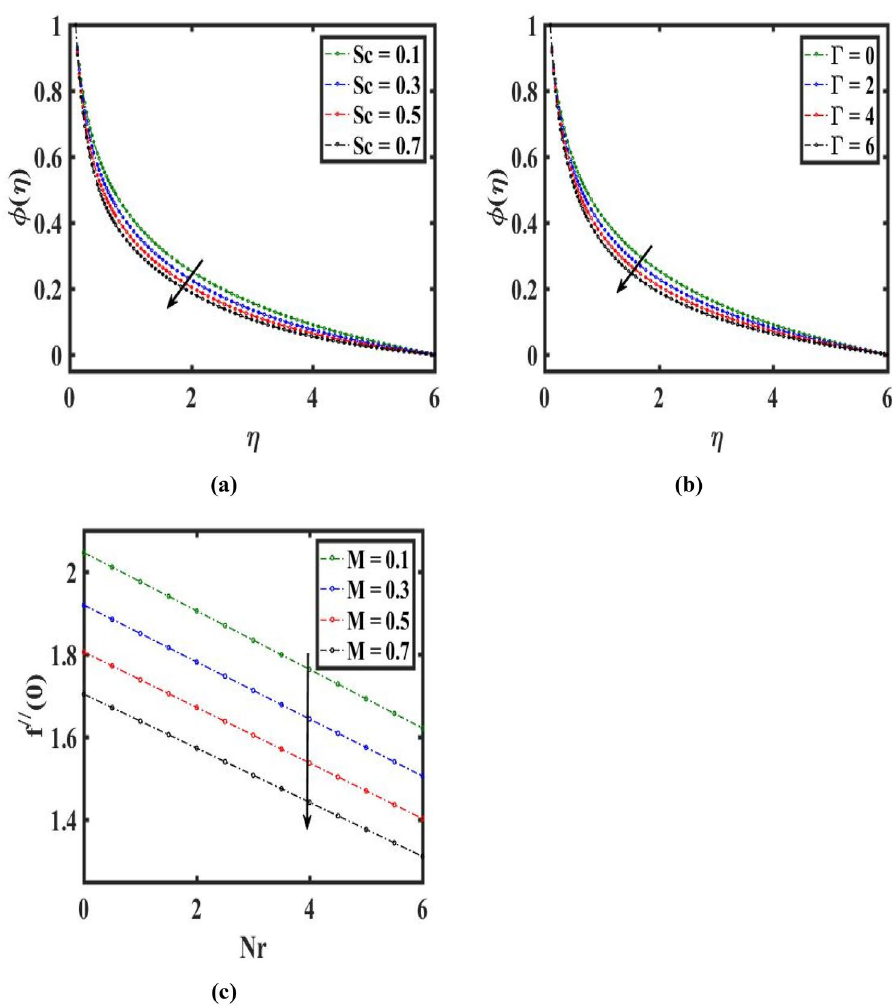
Figure 6. Effect of Schmidt number Sc , chemical reaction Ŵ , Hartmann number M , and buoyance ratio Nr on concentration φ(η) and velocity f ′′ ( 0 )